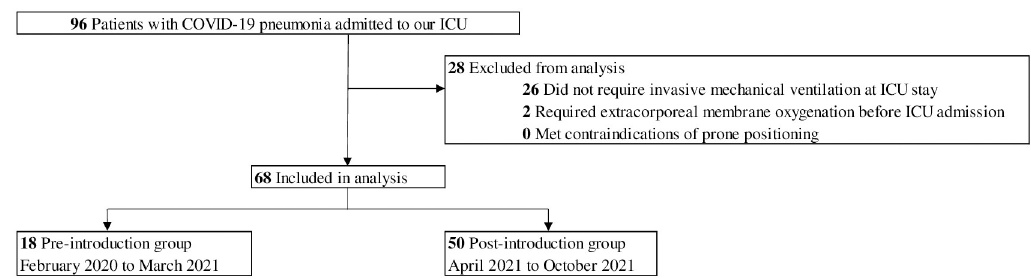
Fig 2. Study flow. We identified 96 patients over 18-years-old with coronavirus disease 2019 (COVID-19) pneumonia in our intensive care unit (ICU); 26 patients did not receive invasive ventilation, and 2 patients who underwent veno-venous extracorporeal membrane oxygenation in a referring hospital were excluded. A total of 68 patients were included in the analysis, with 18 in the pre-introduction group and 50 in the post-introduction group.